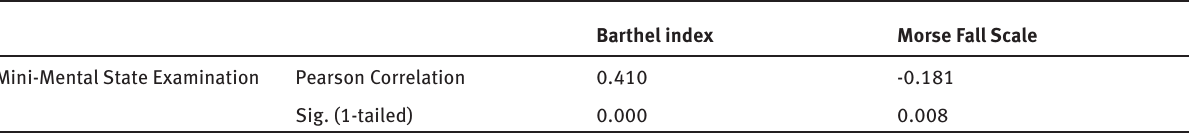
Table 4: Correlation between the scores of the Mini–Mental State Examination and the Barthel Index, as well as the Morse Fall Scale values (n = 177)